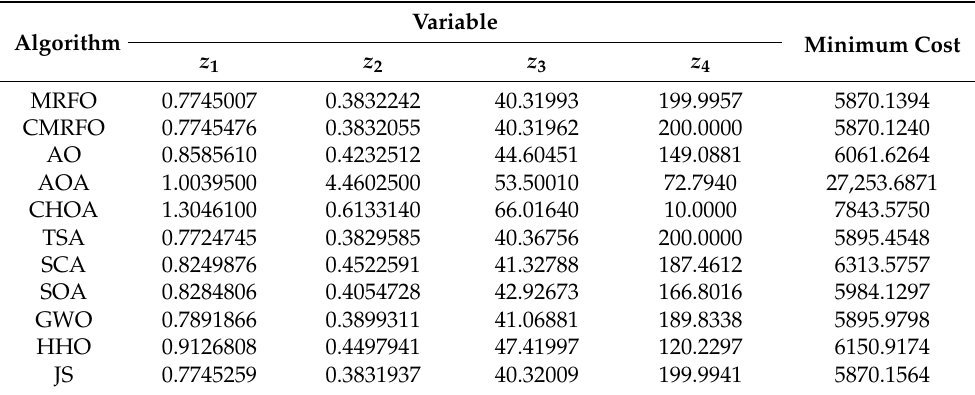
Table 11. Statistical analyses of all 11 algorithms after 30 runs.